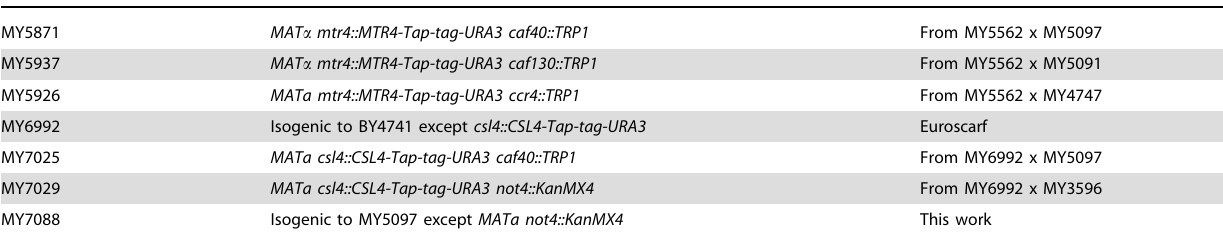
were grown at 30 u C exponentially in high glucose for 24 hours, then diluted to an OD600 of 0.2 and followed for growth during the next 11 hours by measuring the OD600. Found at: doi:10.1371/journal.pone.0006760.s001 (0.23 MB TIF) Figure S2 Accumulation of heterogeneous U14 in mutants of the Ccr4-Not complex. A. Total cellular RNAs isolated from the indicated strains were analyzed by northern blot with a probe against mature U14. The position of mature and extended and polyadenylated U14 is indicated on the right of the blot. A low exposure of the blot was added as a bottom panel to be able to assess the relative levels of mature U14. B. Total cellular RNAs isolated from the indicated strains were analyzed by northern blot with probes against several 3prime-extended snoRNAs (U18, snR71 and U3). The positions of mature and extended snoRNAs are indicated on the right of the blot. Figure S3 Low unspecific background binding of proteins in the tandem affinity purification. Total protein extracts prepared from the indicated strains were subject to the tandem affinity purification protocol. The proteins eluted from the second column were separated by SDS-PAGE and the gel was stained with coomassie. Mass spectrometry analysis of the visible proteins did not reveal any Ccr4-Not complex or exosome subunit (data not shown). Found at: doi:10.1371/journal.pone.0006760.s003 (0.36 MB TIF) Figure S4 Analysis of RNA in glycerol gradient fractionation of total cell extracts. RNA was extracted from 250 microlitre of the glycerol gradient fractions obtained from wild-type cells expressing Tap-tagged Rrp41 (see Fig. 4C, top panel), and these fractions were then analyzed on a 1% agarose gel which was further stained with ethidium bromide to reveal abundant RNAs. The visible tRNAs, and the 18S and 25S rRNAs are indicated. Found at: doi:10.1371/journal.pone.0006760.s004 (0.37 MB TIF) Figure S5 Not5 co-immunoprecipitates with subunits of the exosome and TRAMP complexes. Total protein extracts were prepared from wild-type cells expressing Tap-tagged Rrp45, Rrp46, Mtr3, Rrp43, Rrp40, Rrp4 or Air2, namely from strains MY6425, MY6430, MY6428, MY6429, MY6423, MY5567 or MY7010. 2mg of total protein extracts was incubated with (IP) or without (IP0) antibodies against CBP. 50 mg of total extract (TE), equivalent volume of unbound extract (FT) and the immunopre- cipitate were loaded on SDS-PAGE followed by western blotting with antibodies against Not5, which revealed both Not5 and the Tap-tagged proteins as indicated. Figure S6 RNA is required for the integrity of the largest Rrp41- containing complexes. 5 mg of total protein extracts prepared from wild-type cells expressing Tap-tagged Rrp41 and treated